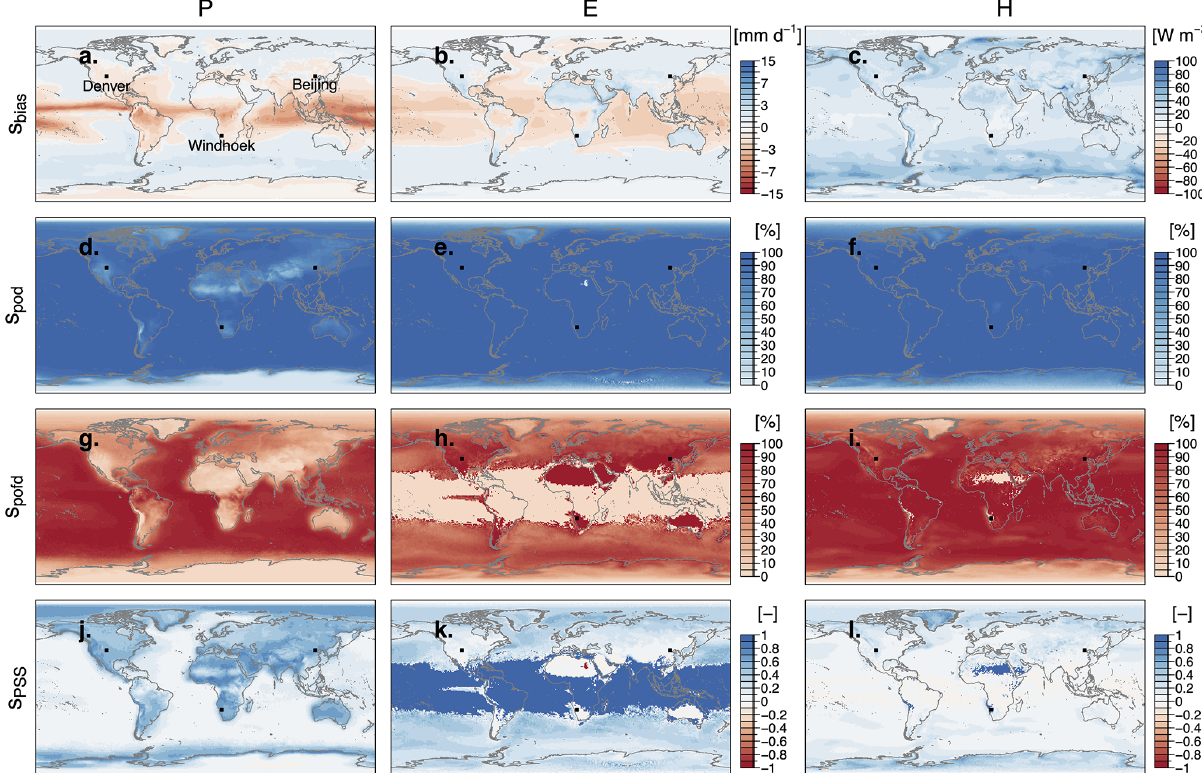
Figure 3. Bias ( s bias ), probability of detection ( s pod ), probability of false detection ( s pofd ), and Peirce’s skill score ( s PSS ) for daily (a, d, g, j) precipitation, (b, e, h, k) surface evaporation, and (c, f, i, l) sensible heat fluxes for the period 1980–2016. Criteria for precipitation detection follow Sodemann et al. (2008) and the Emanuel (1991) convection parameterization. Criteria for surface evaporation and sensible heat fluxes are based on the RH-20 and RH-10, respectively (see Tables 1 and